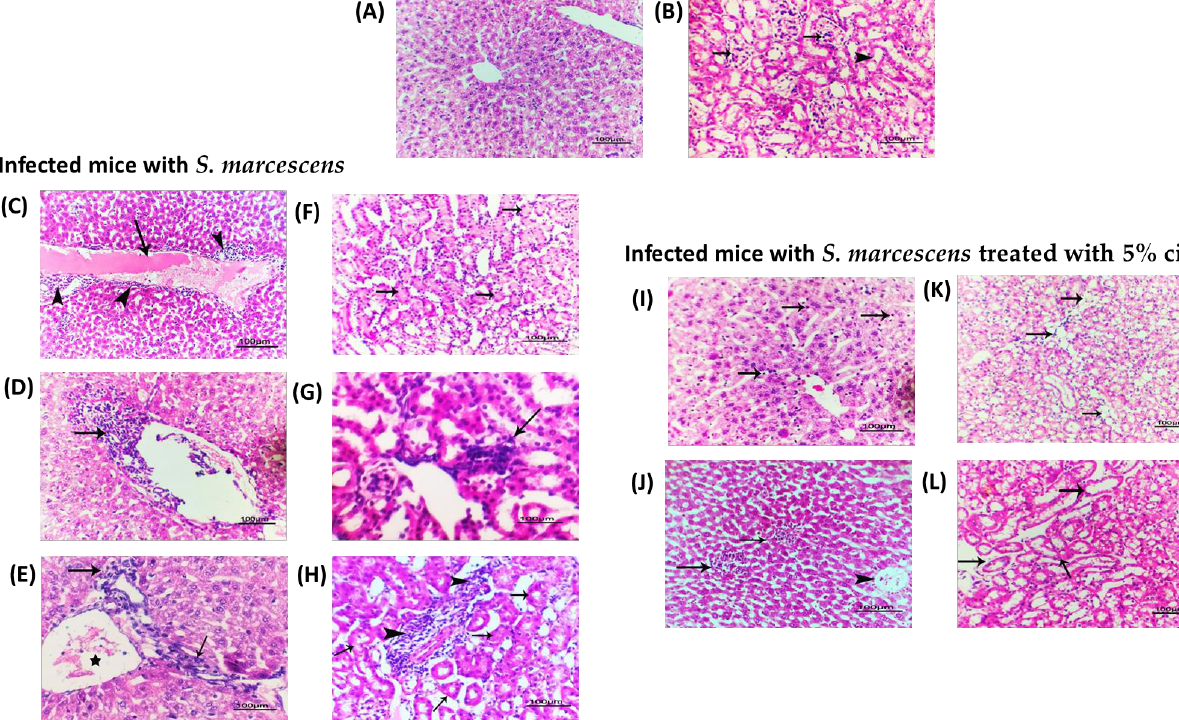
Figure 7. Histopathological investigation of liver and renal tissues. The liver and kidney tissues were isolated from mice groups that were either kept uninfected (negative control), injected with untreated S. marcescens (positive group), or injected with S. marcescens treated with 5% sodium citrate. ( A ) Photomicrograph of H and E-stained liver section of negative control group (uninfected mice) showing normal tissue architecture and cellular details. ( B ) Photomicrograph of H and E-stained kidney section of control group showing normal renal cortex with normal glomeruli (arrows) and renal tubules (arrowhead). Photomicrograph of H and E-stained liver sections of infected group with untreated S. marcescens showing: ( C ) severe congestion of hepatic blood vessels (arrow) with perivascular inflammatory cells infiltration (arrows head), ( D ) massive margination and diapedesis of inflammatory cells (arrow), and ( E ) peri ductal inflammatory cells infiltration (star) with giant cells (arrows). Photomicrograph of H and E-stained kidney sections of infected group with untreated S. marcescens showing: ( F ) atrophy and degeneration of some renal tubules (arrows), ( G ) focal area of leucocytic cells infiltration (arrows), and ( H ) perivascular inflammatory cells infiltration (arrows head) with individualization and atrophy of some renal tubules (arrows). Photomicrograph of H and E-stained liver sections of mice group injected with 5% citrate-treated S. marcescens showing: ( I ) normal tissue architecture with diffuse von Kupffer cells infiltration (arrows), and ( J ) mild congestion of hepatic blood vessels (arrowhead) with mild inflammatory focal cells infiltration. Photomicrograph of H and E-stained kidney sections of mice group injected with 5% citrate-treated S. marcescens showing: ( K ) minimal focal areas of cystic dilation of some renal tubules (arrows), and ( L ) mostly normal renal medulla with mild focal individualization of some renal tubules (arrows). (Scale bar =100 μm).